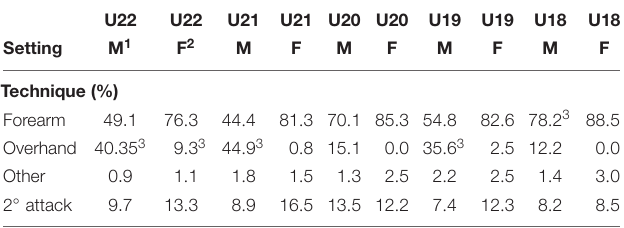
TABLE 2 | Distribution types of setting across age and gender.